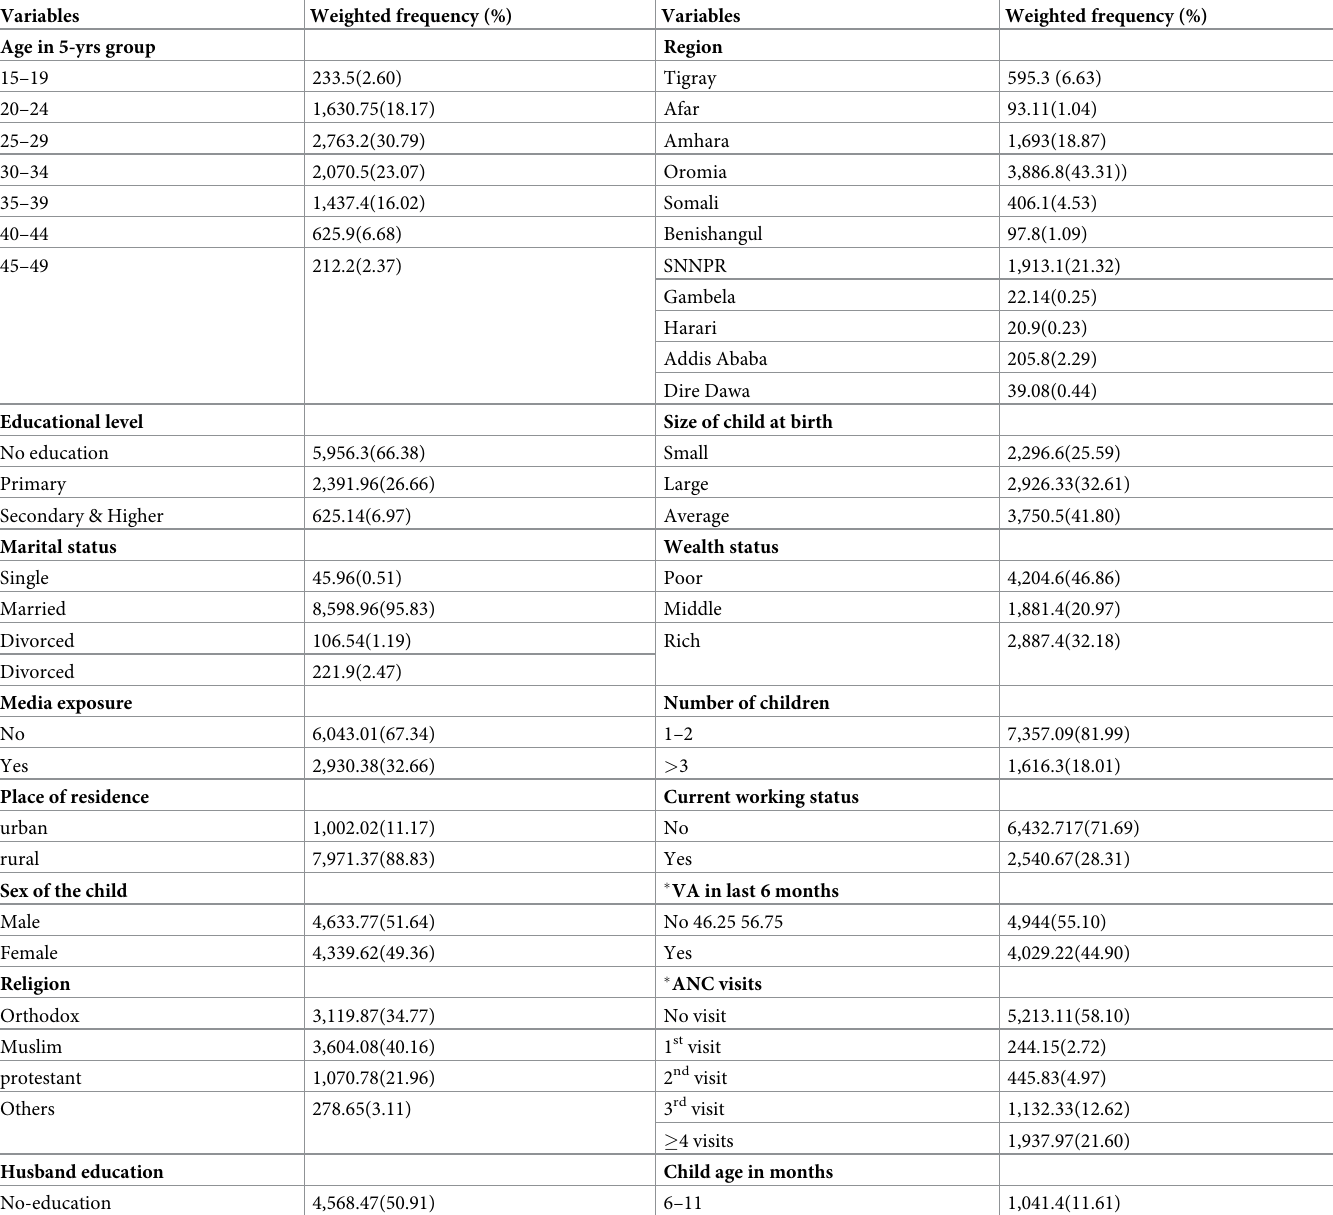
Table 1. Socio-demographic characteristics of respondent among children aged 6–59 months in Ethiopia, EDHS